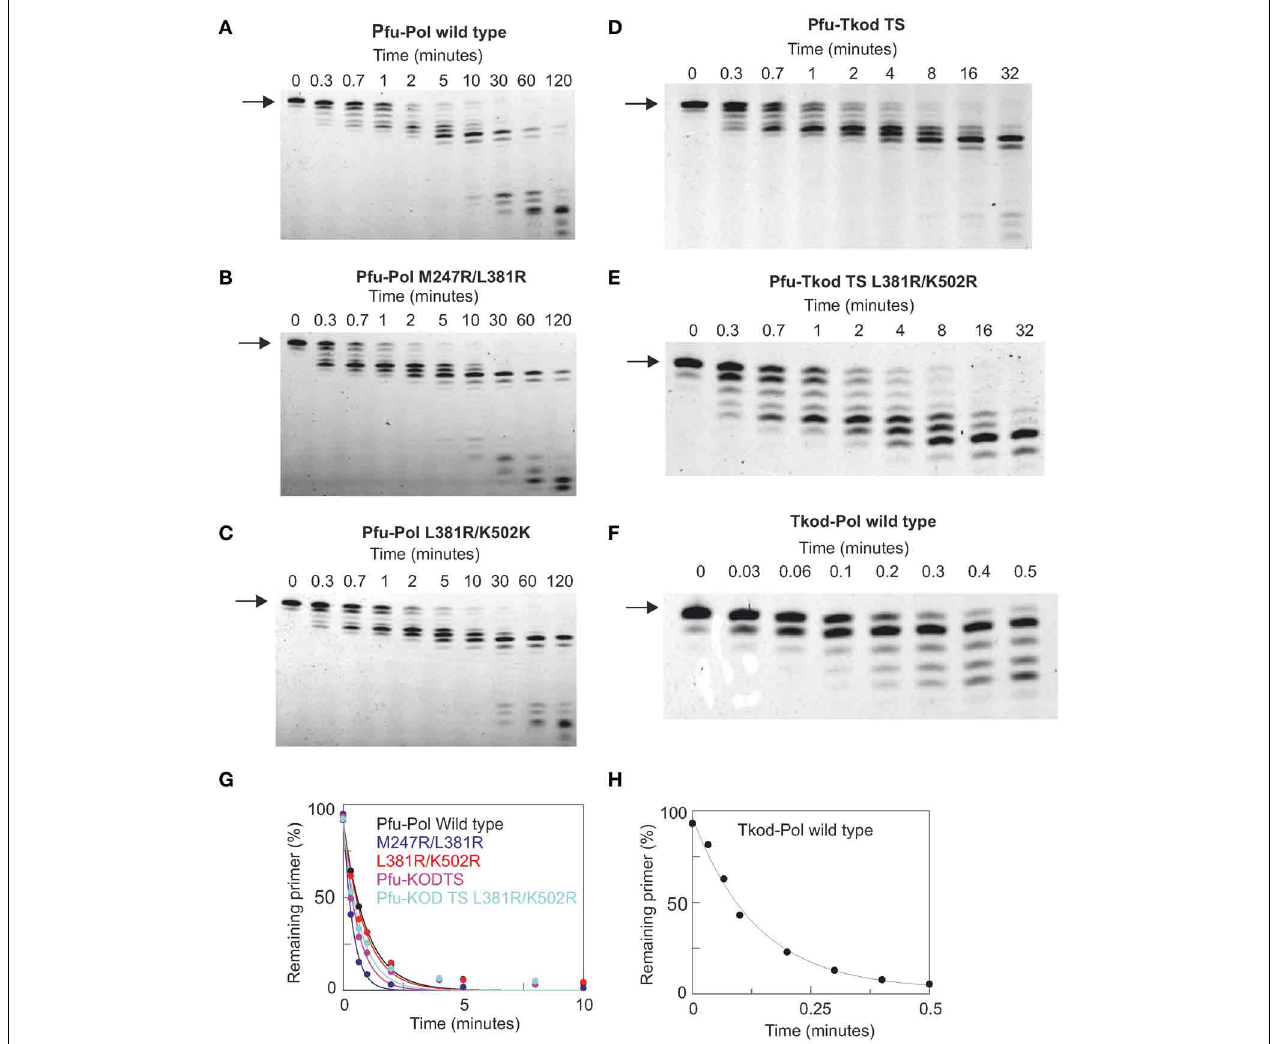
FIGURE 6 | Proof reading 3 (cid:3) -5 (cid:3) exonuclease activity by archaeal family-B DNA polymerases. (A–F) Gel electrophoresis analysis of primer strand degradation seen with a base mismatch primer-template using the polymerase variants indicated. The starting primer is shown arrowed. Panels (G) and (H) show fits of the data (as % primer remaining with time) to a single